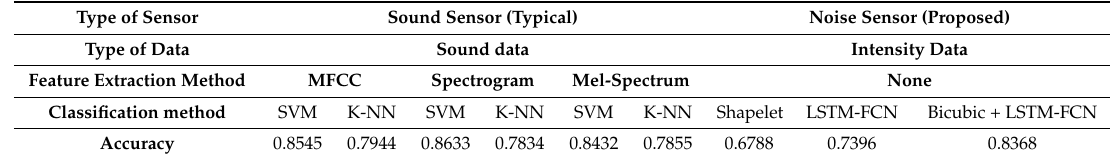
Table 7. Classification accuracy applied to each model.